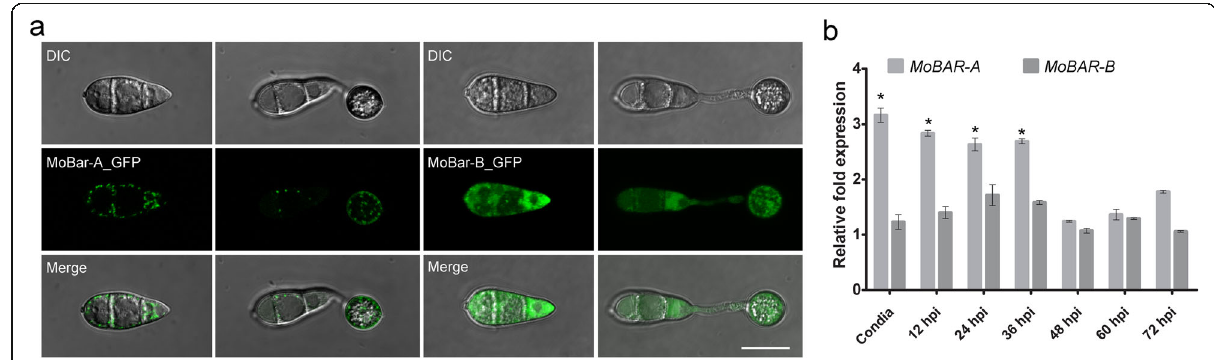
Fig. 2 Subcellular localization of MoBar-A and MoBar-B in Magnaporthe oryzae and the expression level of their respective genes during fungal infection. a The localization pattern of GFP/MoBar-A and MoBar-B/GFP in asexual spore and during spore germination and appressorium formation. Localization of GFP/MoBar-A and MoBar-B/GFP were visualized by Nikon laser confocal and laser excitation epifluorescence microscopy, the scale bar is 10 μ m. b The relative expression level of MoBAR-A and MoBAR-B in the asexual spores and at different stages of infection in-planta by qPCR. The error bars represent standard errors from at least three independent replicates (*, P < 0.05 by t-test). The expression of M. oryzae actin gene in the mutants and the wild-type strain at each stage of infection was used as the internal control. The expression level of MoBAR-A and MoBAR-B during the development of vegetative hyphae was used as control stage and was assumed as unity (the expression level of MoBAR-A and MoBAR-B at hyphal stage